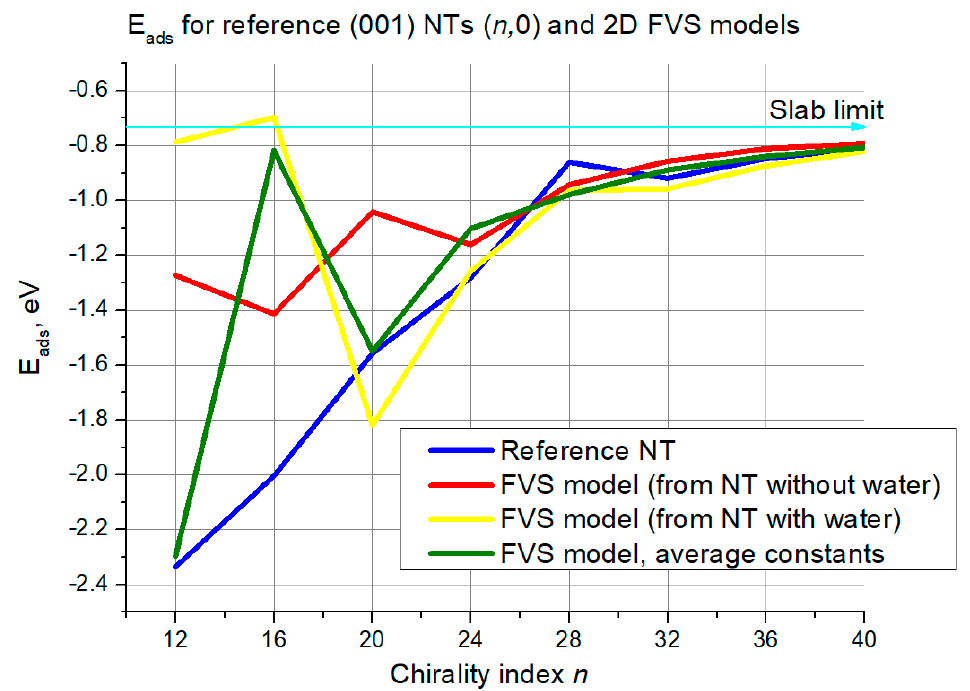
Figure 12. Adsorption energies for (001) NTs ( n ,0) and their 2D FVS models. The cyan line with the arrow denotes the slab limit for water adsorption energy.